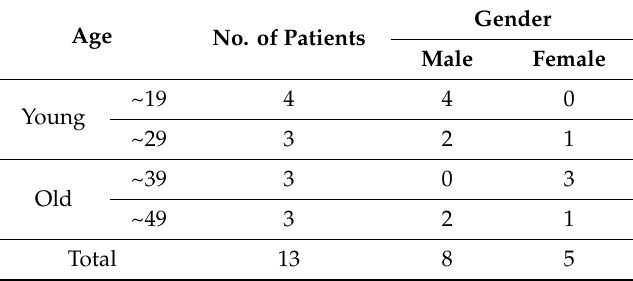
Table 1. Clinical information of patient samples analyzed for immunohistochemical expression of visfatin in dental pulp tissues of subjects with young group and old group. Gender Age No. of Patients Male